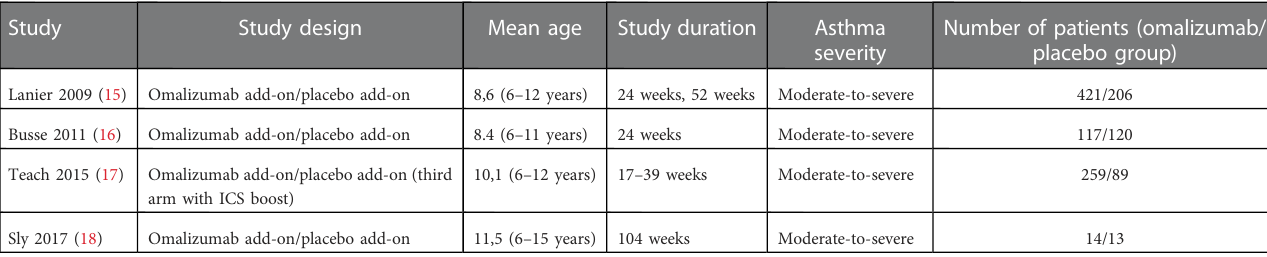
TABLE 1 Demographic and clinical characteristics of the selected